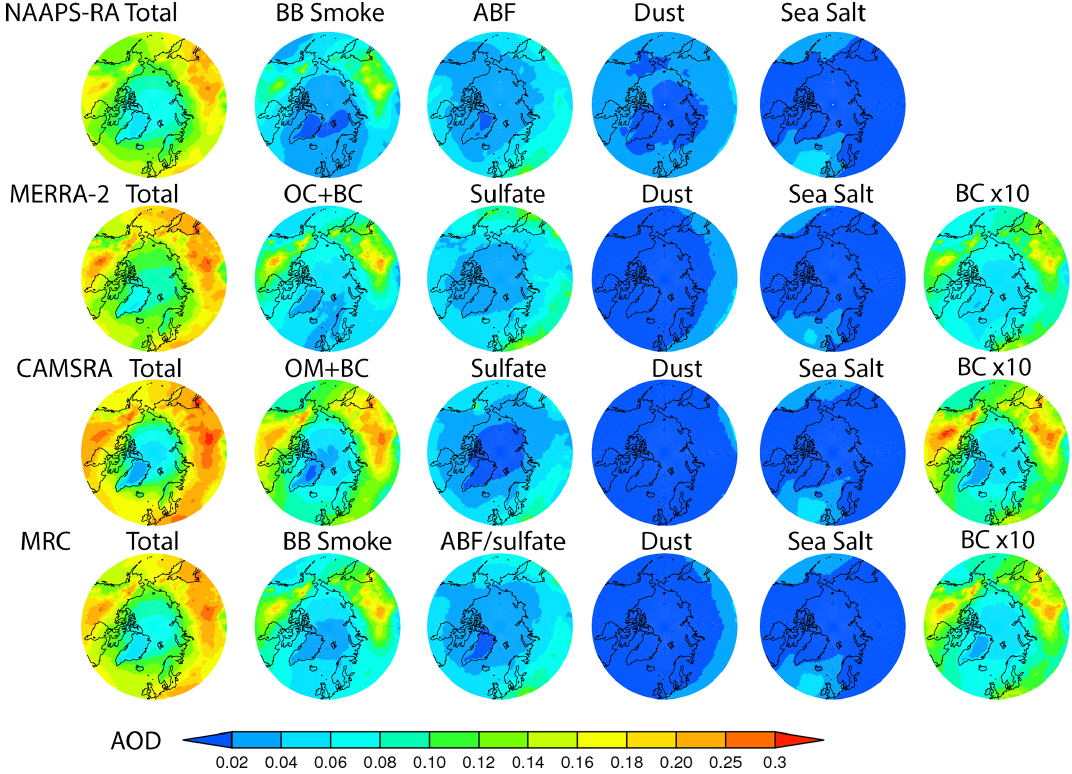
Figure 5. Same as Fig. 4 except for